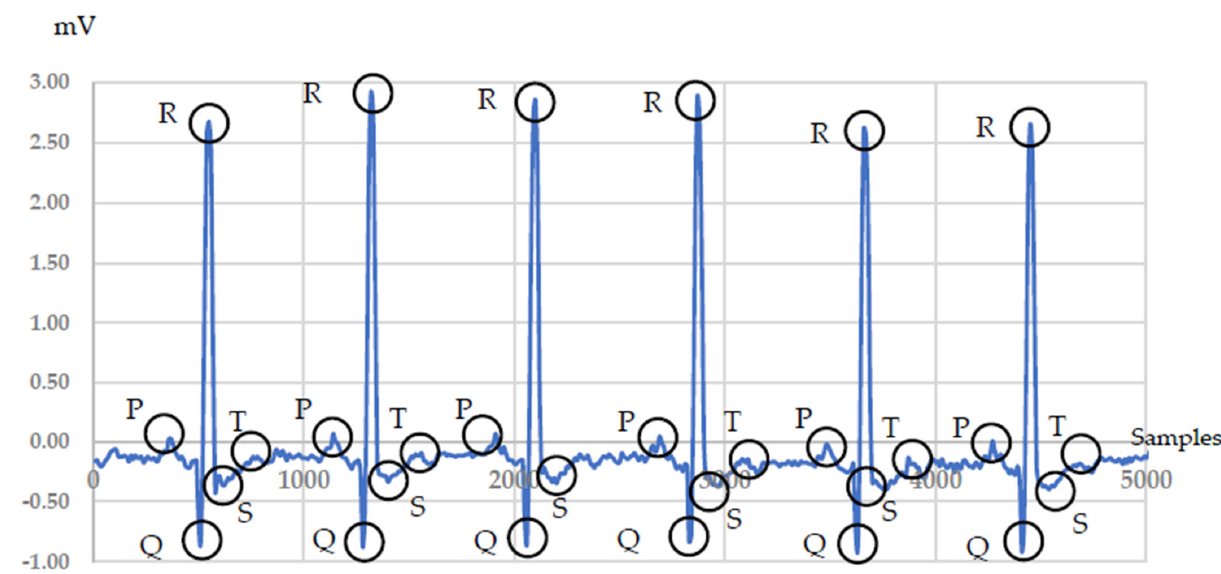
Figure 3. Example of P ‐ QRS ‐ T detection using the CWT